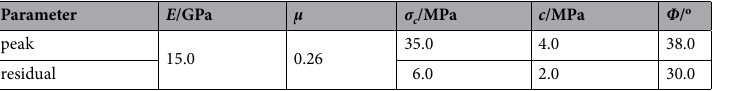
Table 1. Rock mechanical parameters of tunnel surrounding rock. E : Young’s modulus; μ : Poisson’s ratio; σ c : Compressive strength of intact rock; c : Cohesive force; Φ : Internal friction